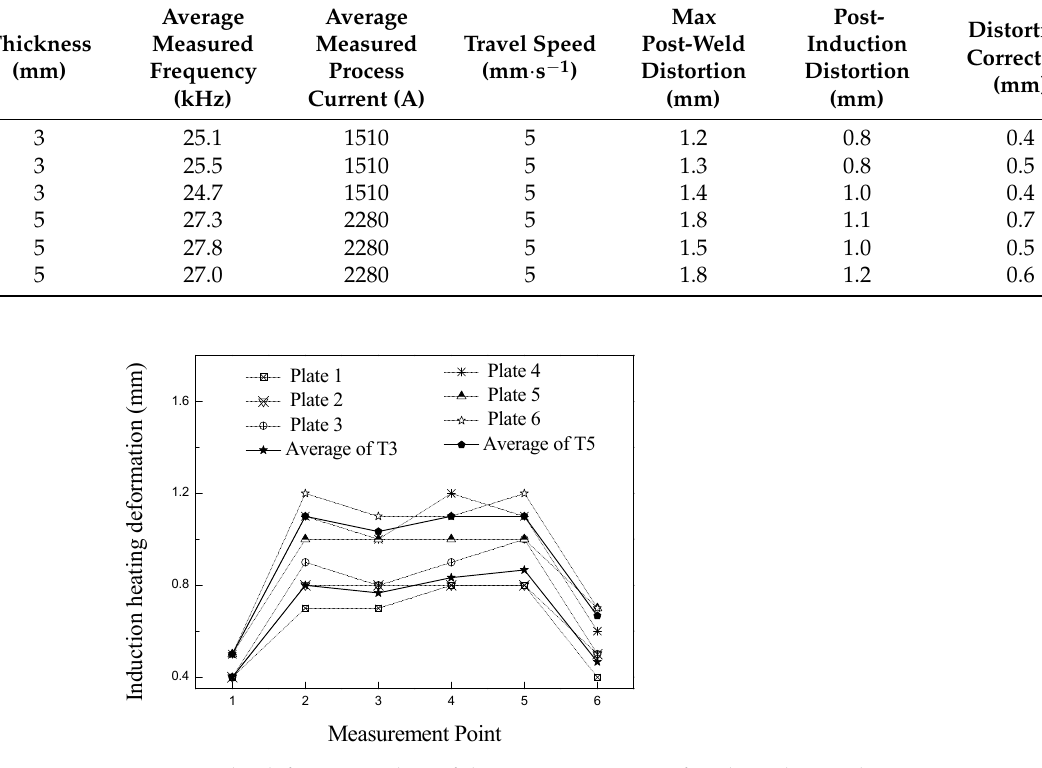
Figure 7. The deformation data of the measuring point after the induction heating experiment.